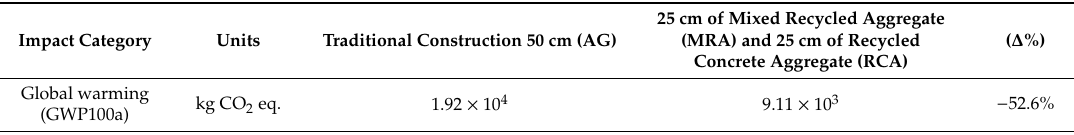
Table 12. CO 2 emissions generated by construction of 8200 m 2 port loading platform with RCA